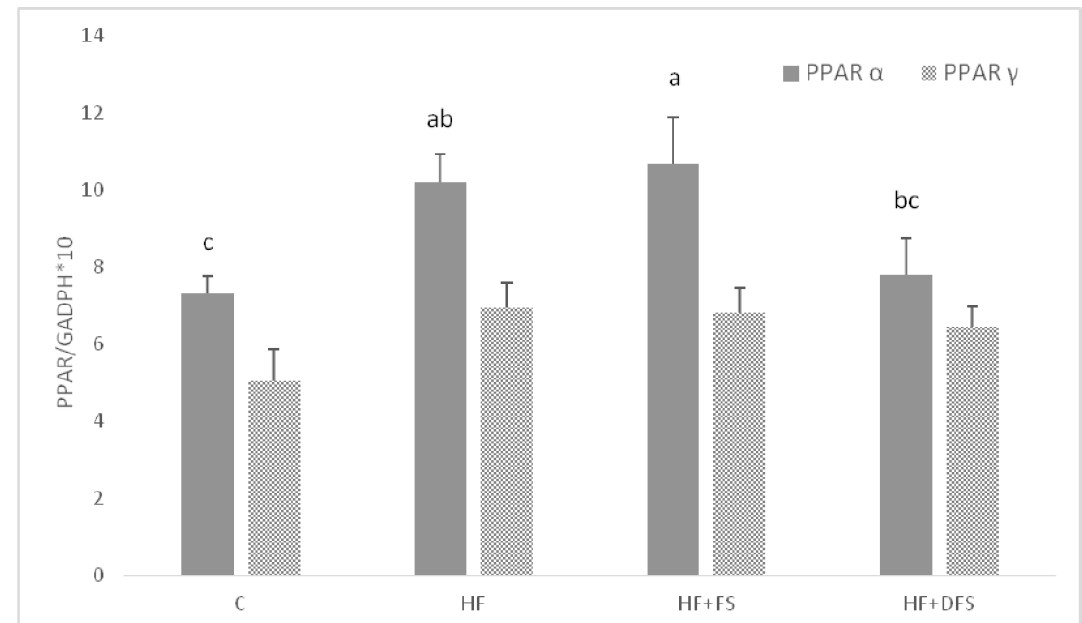
Figure 1. qRT-PCR analysis of PPAR α and PPAR γ mRNA expression in rat livers. All values are expressed as the mean ± SEM ( n = 8). Values not sharing the same superscript ( a,b,c ) within a row are different at p ≤ 0.05. C: group fed a standard diet for laboratory rodents; HF: group fed a high